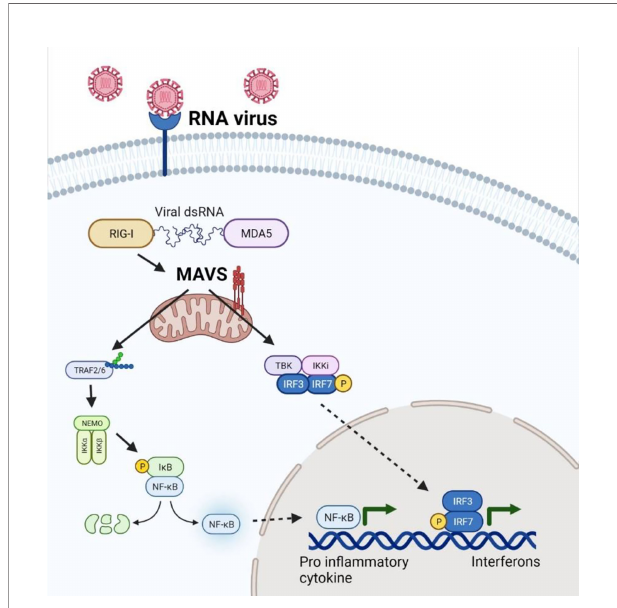
FIGURE 1 | MAVS-mediated Antiviral and In fl ammatory response during RNA virus infection. MAVS acts as a central hub to recognize the RIG-I mediated sensing of viral RNA in the host cell leading to a trigger of NFkB and IRFs activation leading to transcription of genes regulating in fl ammatory and antiviral response during viral